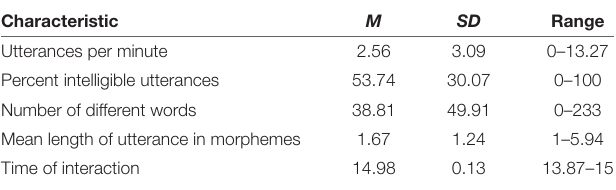
TABLE 3 | Characteristics of child spoken